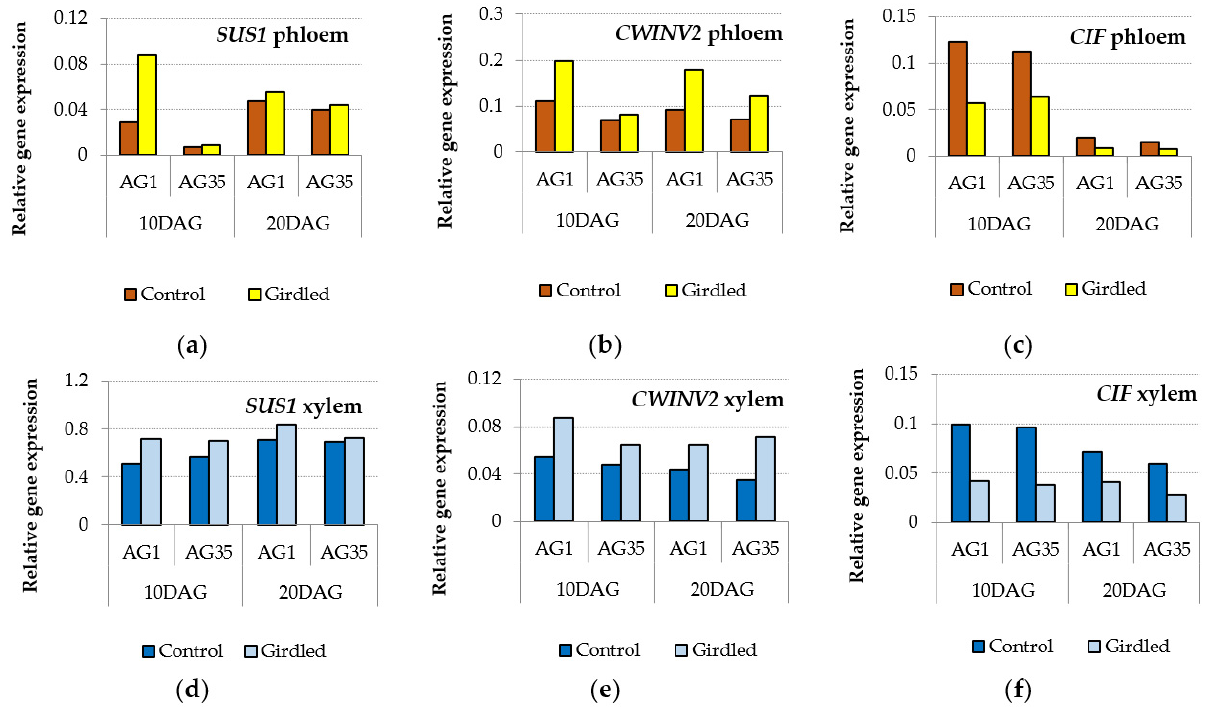
Figure 9. Relative gene expression of SUS1 ( a , d ), CWINV2 ( b , e ), and CIF ( c , f ) genes in the phloem ( a – c ) and xylem ( d – f ) of control and girdled trees. Genes encoding sucrose ( SUC ) and hexose transporters ( HEX1 and HEX2 ) showed